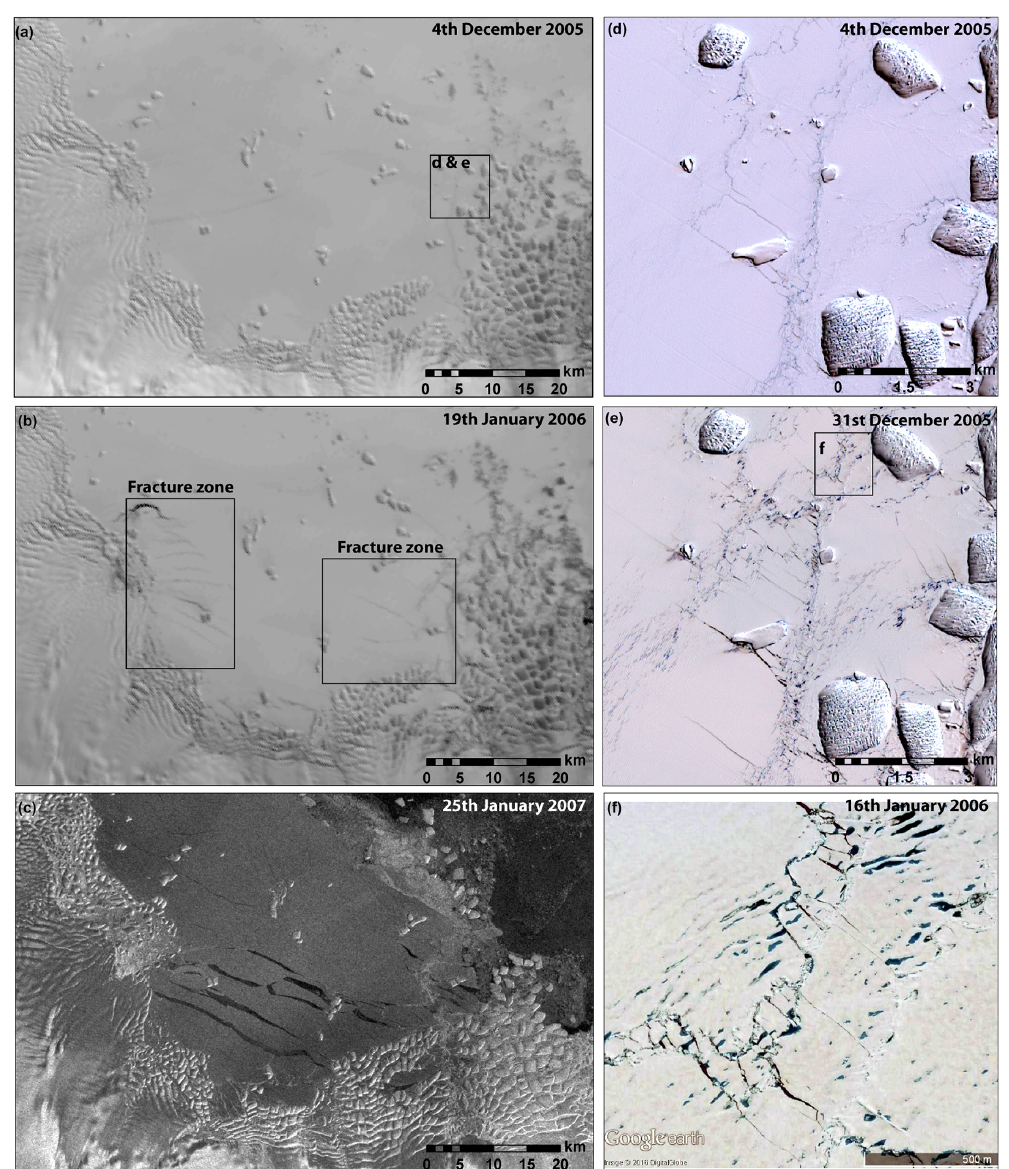
Figure 13. (a, b) MODIS imagery showing the development of fractures in the landfast sea ice between 4 December 2005 and 19 Jan- uary 2006 (Scambos et al., 1996; http://dx.doi.org/10.7265/N5NC5Z4N). (c) The landfast sea ice ruptures along some of the same fractures which formed in December/January 2005/2006, eventually leading to complete break-up in January 2007. (d, e) ASTER imagery showing surface melt features and the development of smaller fracture between 4 and 31 December 2005. (f) High-resolution optical satellite imagery from 16 January 2006 showing sea ice fracturing and surface melt ponding. This image was obtained from Google